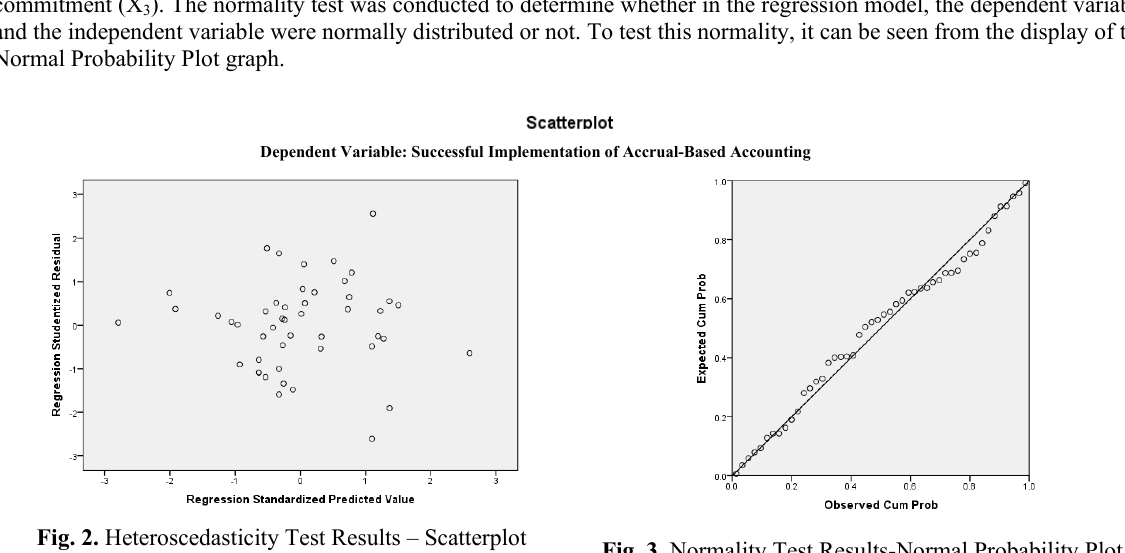
Fig. 3. Normality Test Results-Normal Probability Plot Graph